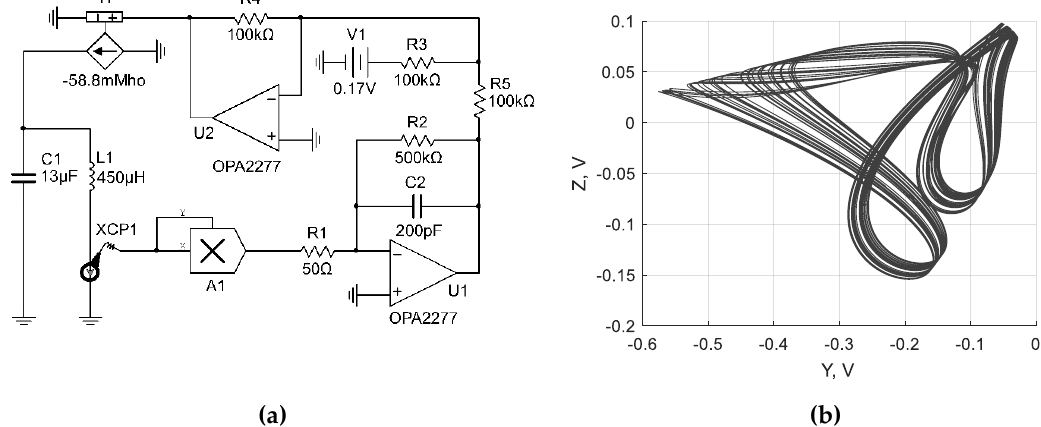
Figure 3. Chaotic circuit based on the Sprott Case H system with inductive element ( a ); corresponding attractor of the circuit ( b ).